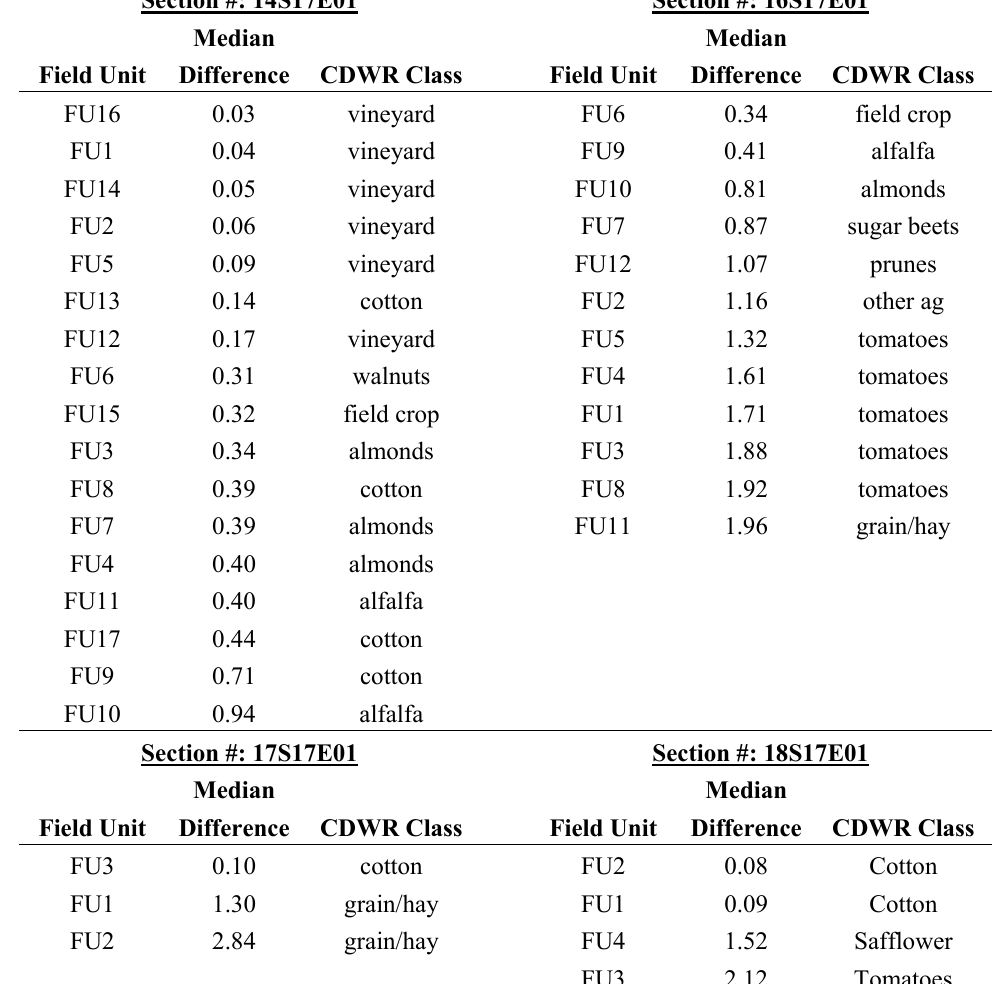
Table 2. Field identification results for each of the study Sections. Results are sorted from lowest to highest median difference